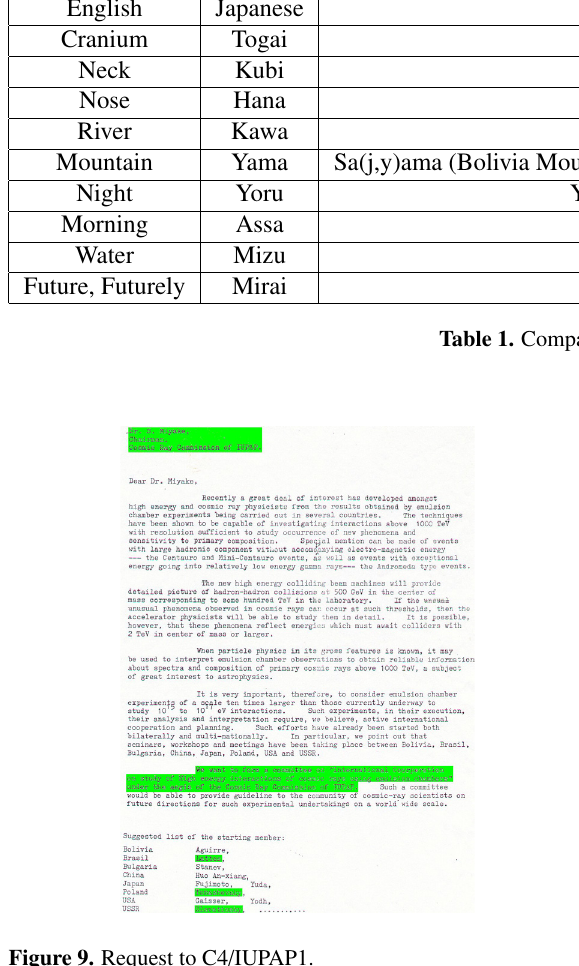
Figure 9. Request to C4 / IUPAP1.